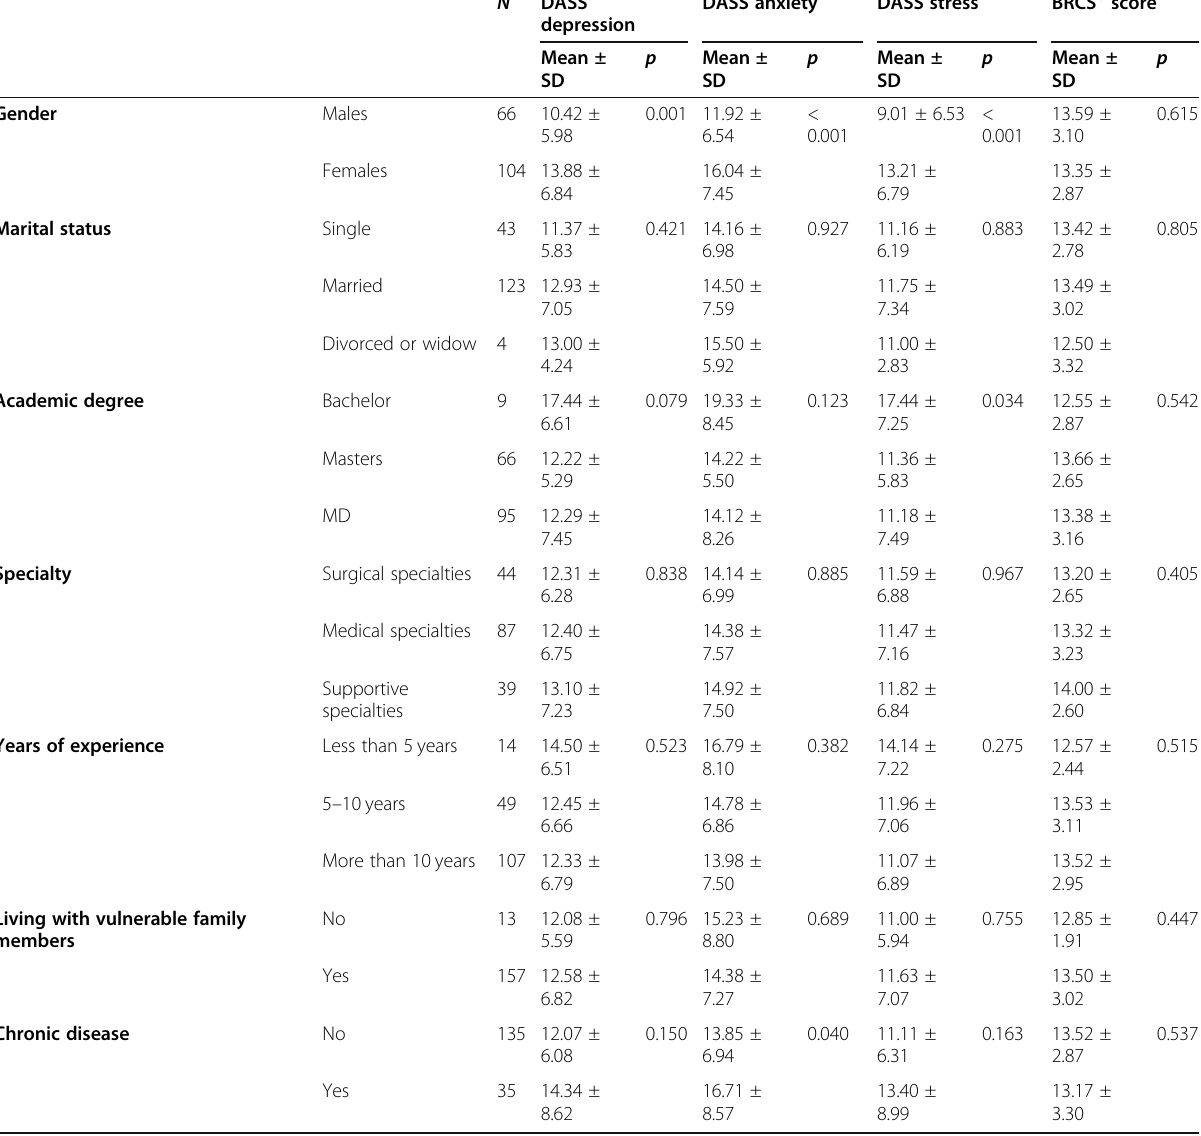
Table 4 Relation between demographics and clinical characteristics of the physicians